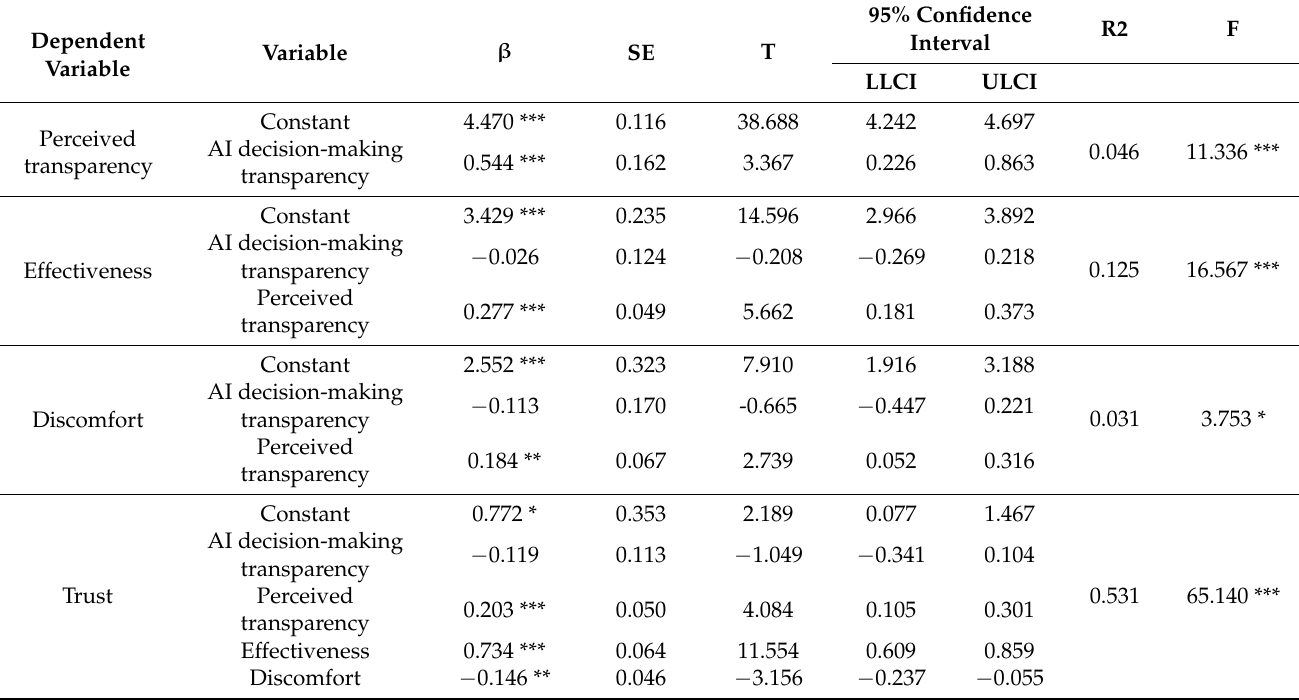
Table 4. Model test of mediation